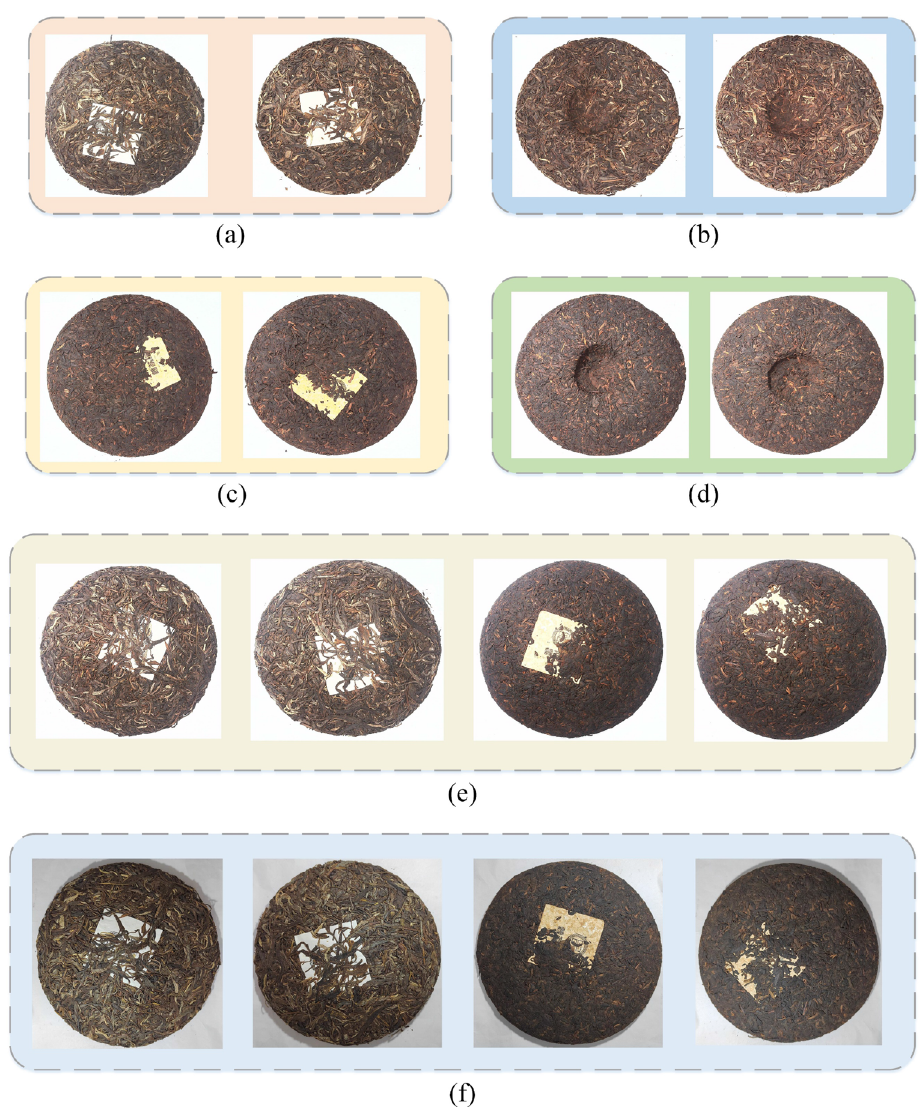
Figure 2. ( a )–( d ) are examples of Pu-erh tea face datasets. ( a ) Pu-erh raw tea face image (front), ( b ) Pu-erh raw tea face image (back), ( c ) Pu-erh ripe tea face image (front), ( d ) Pu-erh ripe tea face image (back). ( e ), ( f )